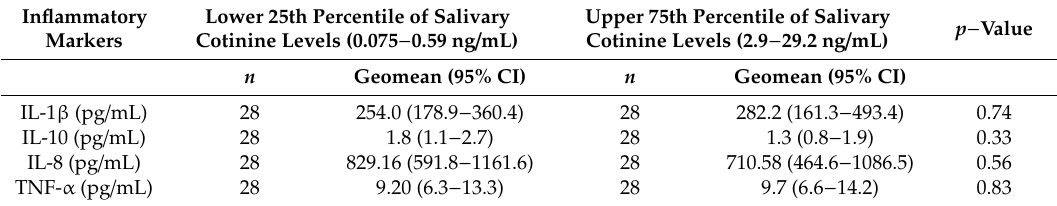
Table 4. Inflammatory marker value di ff erences between the lower 25th percentile and upper 75th percentiles of log-cotinine values a